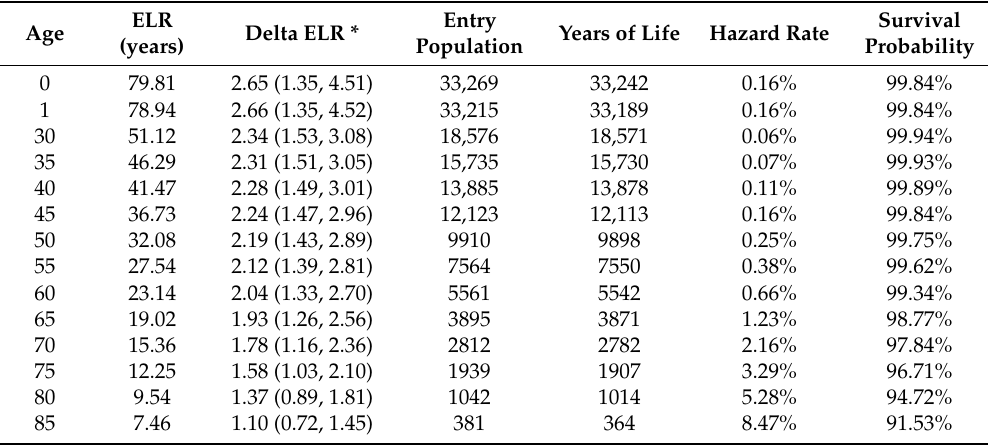
Figure 2. AirQ+ life table evaluation for the year 2015 at the measured PM 2.5 level (87.9 μ g/m 3 ). Table 5. Expected Life Remaining (ELR) and other parameters for different age groups.